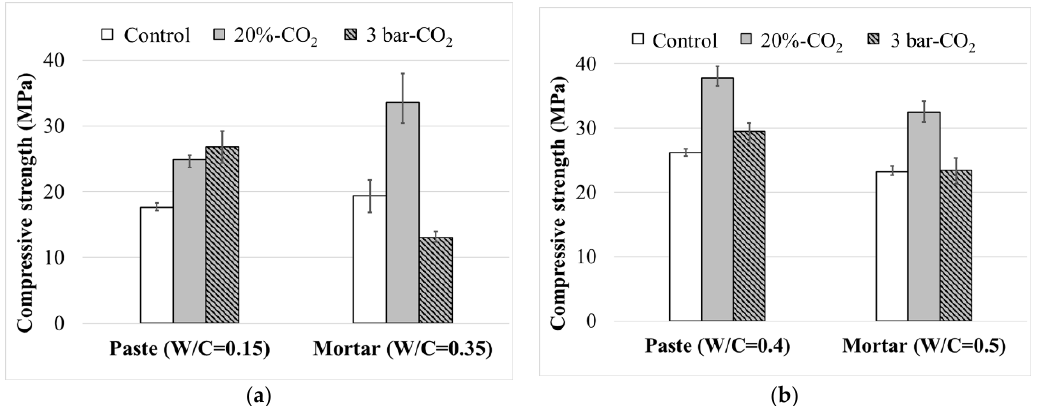
Figure 3. Strength of 1-day samples fabricated by ( a ) compacting and ( b ) consolidating-in-mold method.